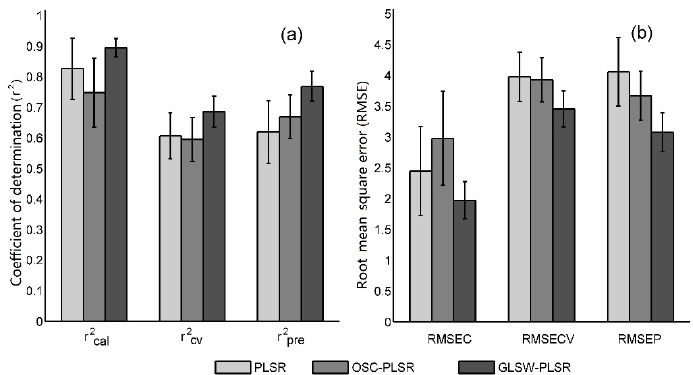
Figure 5. Mean values of ( a ) r 2 and ( b ) RMSE in prediction of SOC content at various moisture contents using three methods: PLSR, OSC-PLSR, and GLSW-PLSR, respectively. The error bars denote one standard deviation.